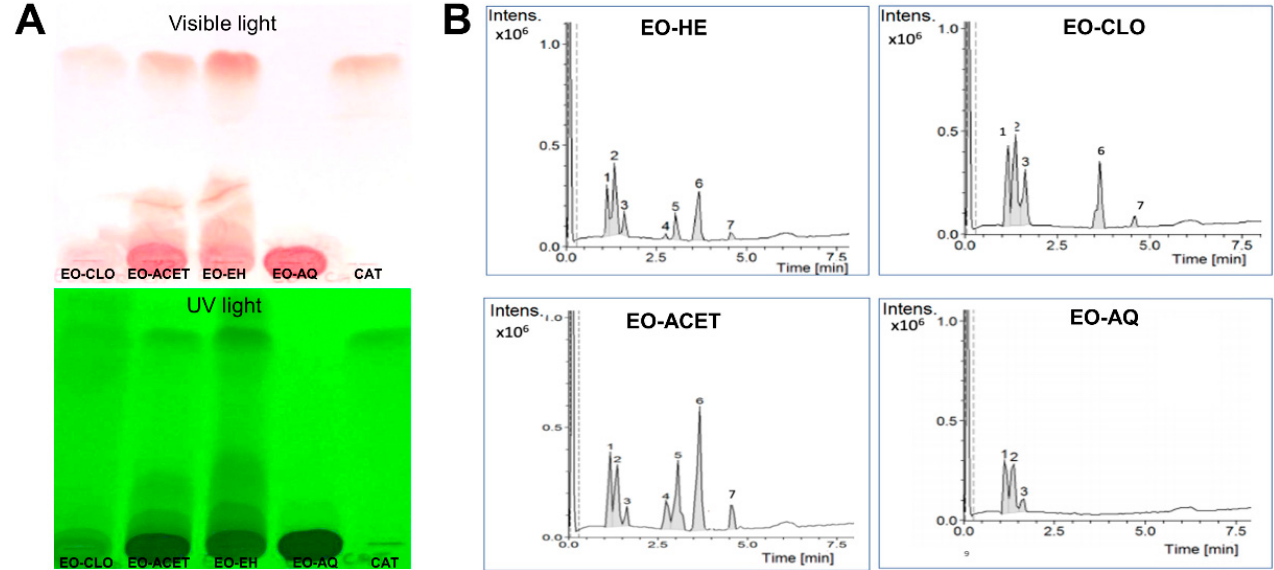
Figure 2. Chromatograms obtained by thin-layer chromatography ( A ) and high-performance liquid chromatography coupled to the mass spectrometer ( B ) of the hydroalcoholic extract of Euterpe oleracea seeds (EO-HE) and fractions obtained using chloroform (EO-CLO), ethyl acetate (EO-ACET) and water (EO-AQ), showing the presence of seven main signs. Table 1. Constituents found in Euterpe oleraceae seed extracts with their respective molecular pseudo-ions, relative percentage areas and their tentative identification.